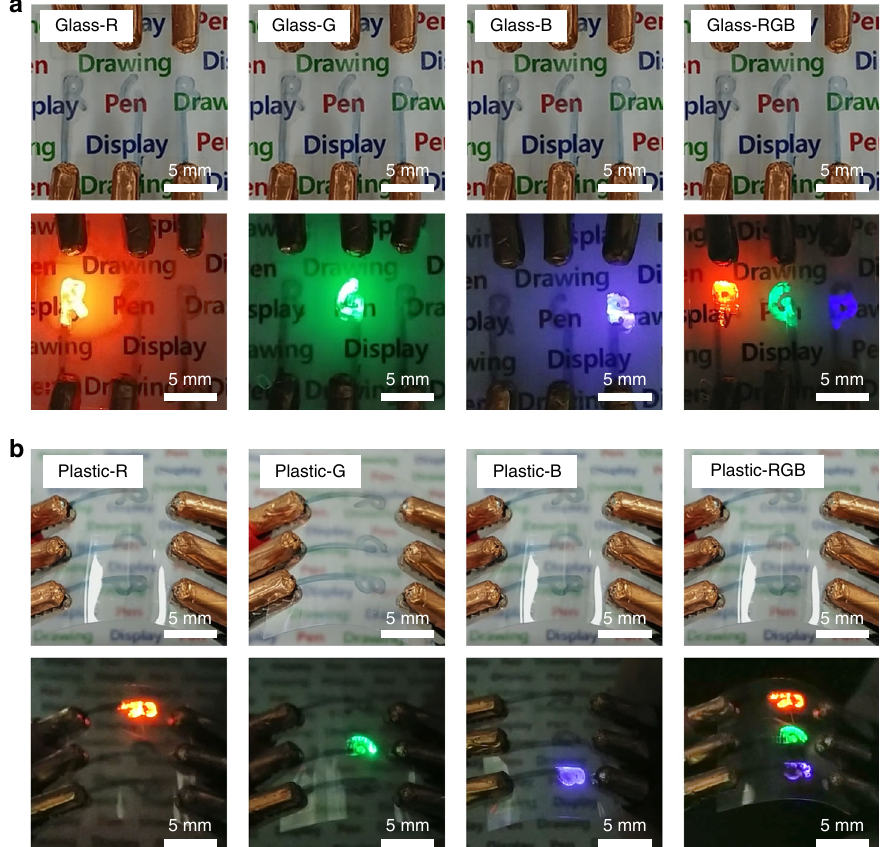
Fig. 6 Handwriting display images using the pen-drawing method. Photo images of “ RGB ” text displays formed on the glass ( a ) and plastic ( b ) substrates, showing the optical clarity and mechanical fl Fig. 5f, the electroluminescence spectrum of the pen-drawn QD- LEDs had maximum peaks of 643 (R), 557 (G), and 455 nm (B) with remarkably narrow full-width-at-half-maximum values of 38 (R), 25 (G), and 24 nm (B). Thus, the fabricated device can afford exceptional color purity. As indicated in the inset of Fig. 5f, the pen-drawn QD-LEDs showed the Commission Internationale de l'Elcairage (CIE) color coordinates of (0.66, 0.34) (R), (0.16, 0.78) (G), and (0.15, 0.03) (B).